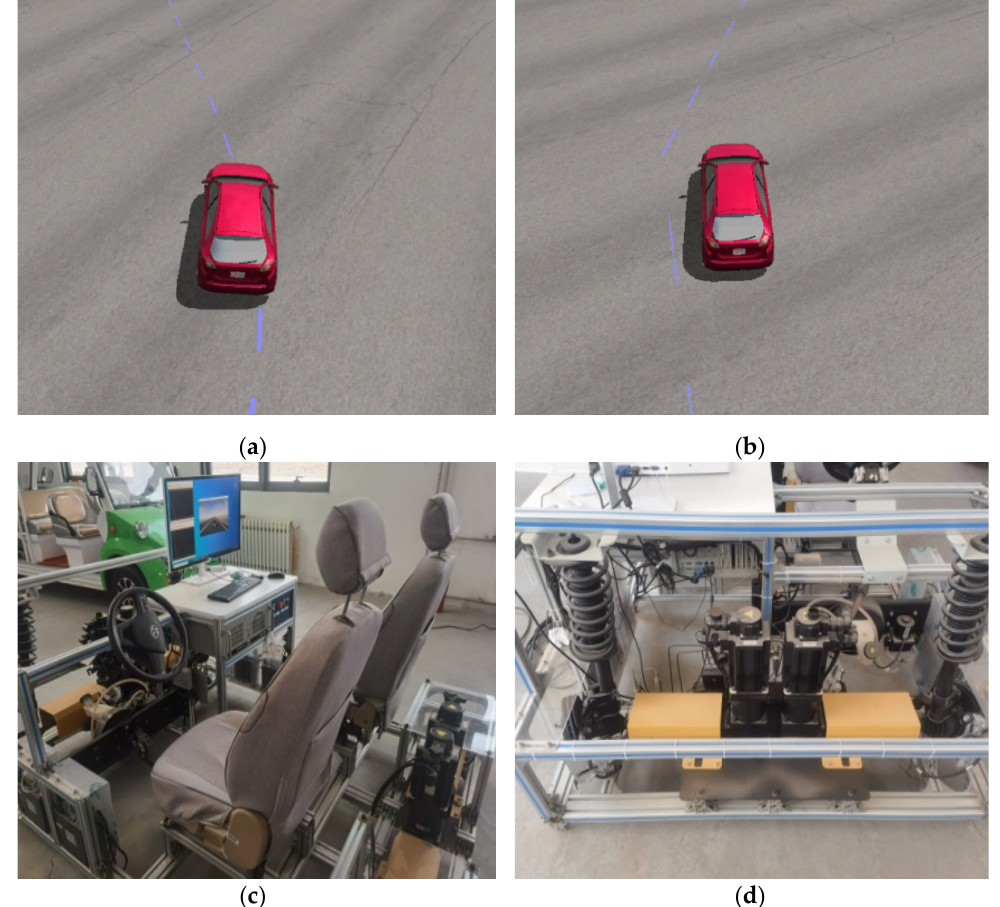
Figure 13. Matlab-Carsim HIL simulation platform test: ( a ) improved trajectory tracking; ( b ) general algorithm; ( c ) Matlab-Carsim HIL simulation platform 1; ( d ) Matlab-Carsim HIL simulation platform 2.